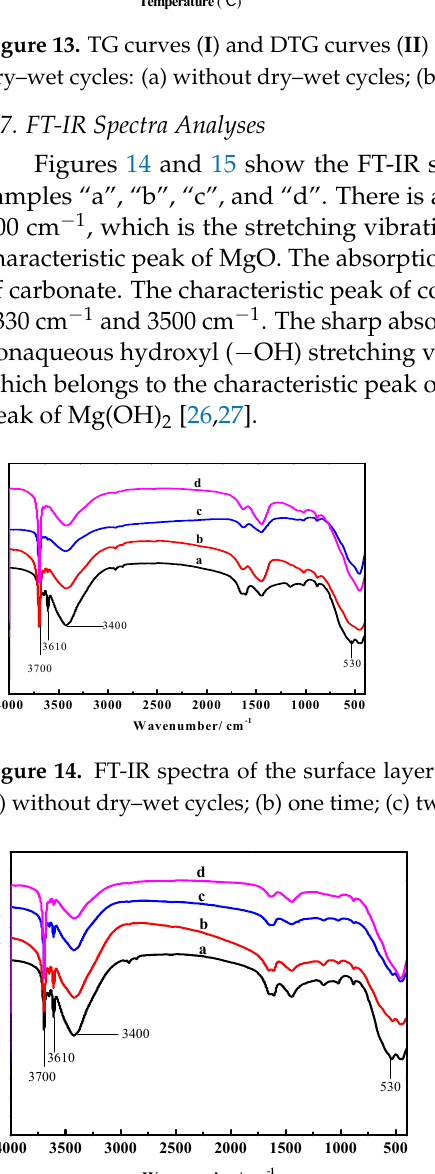
Figure 13. TG curves ( Ⅰ ) and DTG curves ( Ⅱ ) of the inner cores of the MOC samples after different dry–wet cycles: (a) without dry–wet cycles; (b) one time; (c) two times; (d) three times.